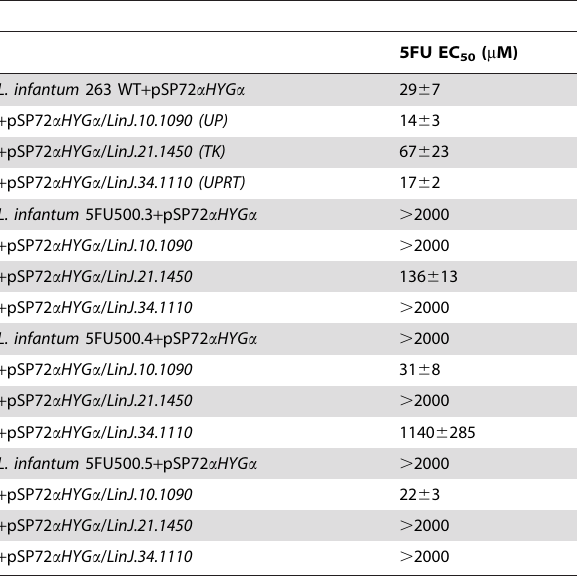
Table 3. Resistance to 5-fluorouracil in 5-FU resistant mutants genetically complemented with WT alleles.